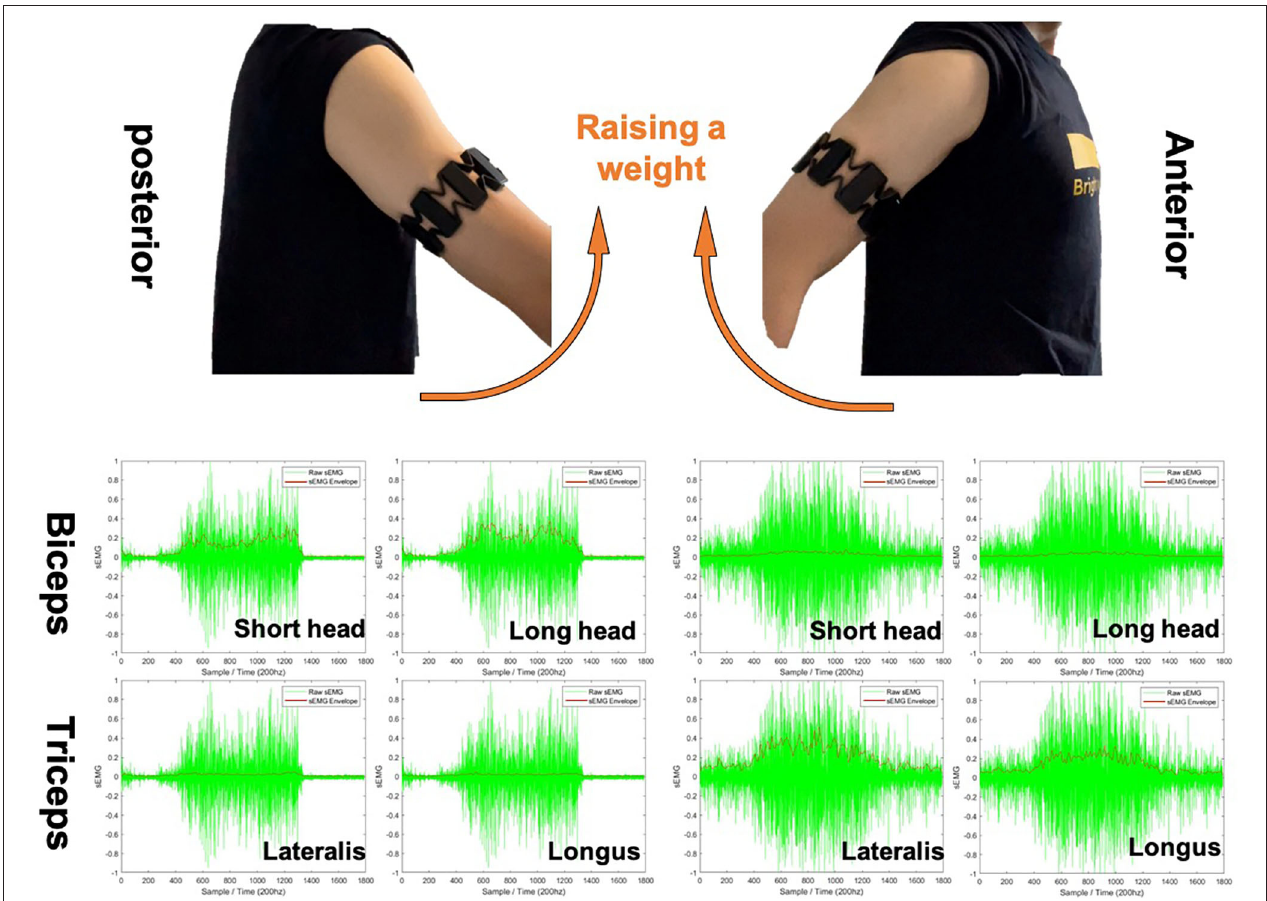
FIGURE 4 | Typical example of surface electromyography (sEMG) envelope computing used in this paper based on Butterworth filter with a cut-off frequency of 5 Hz. Four sEMG channels are taken into account that cover the antagonist muscle pair biceps and triceps. The green signals are the raw sEMG signal, and the red line are the computed envelopes. Sampling interval is 10